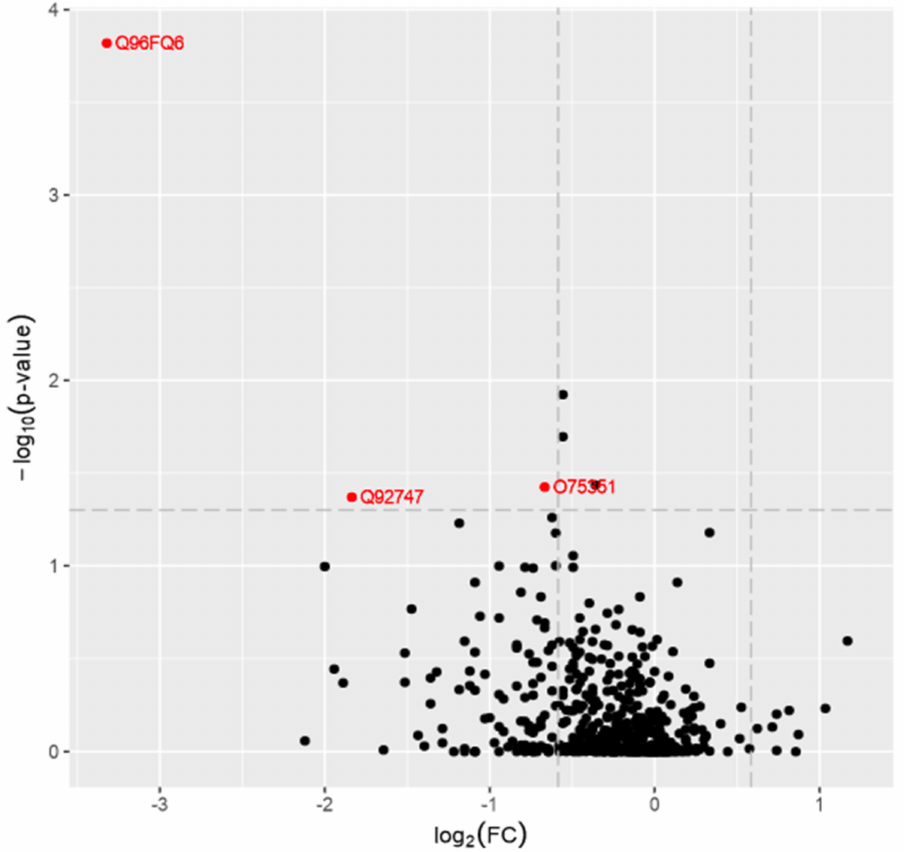
Figure 2. A volcano plot from the mass spectrometry data is shown. The x-axis shows the fold change values and the y axis shows the − log 10 p-values showing statistical significance. Q96FQ6–S100A16